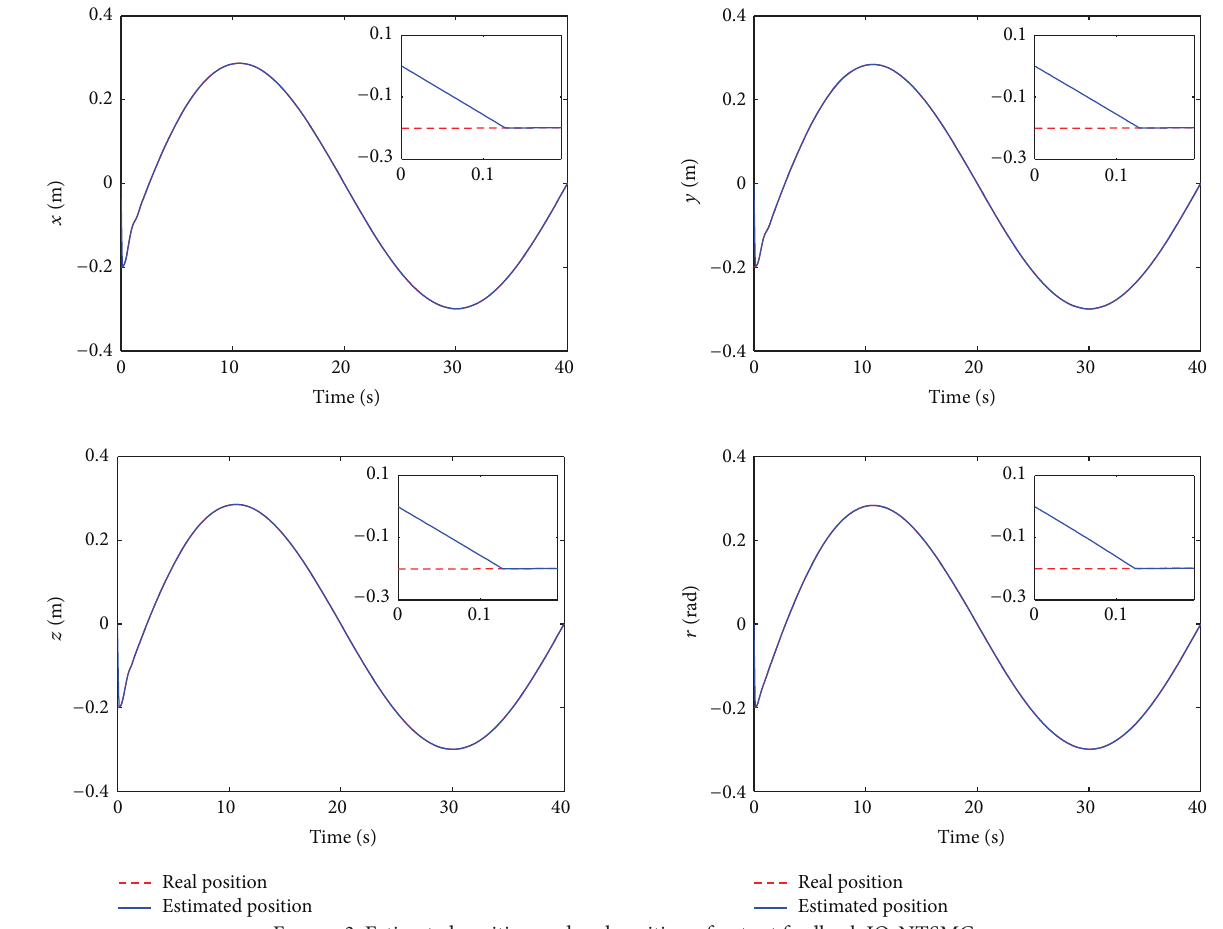
Figure 3: Estimated position and real position of output feedback